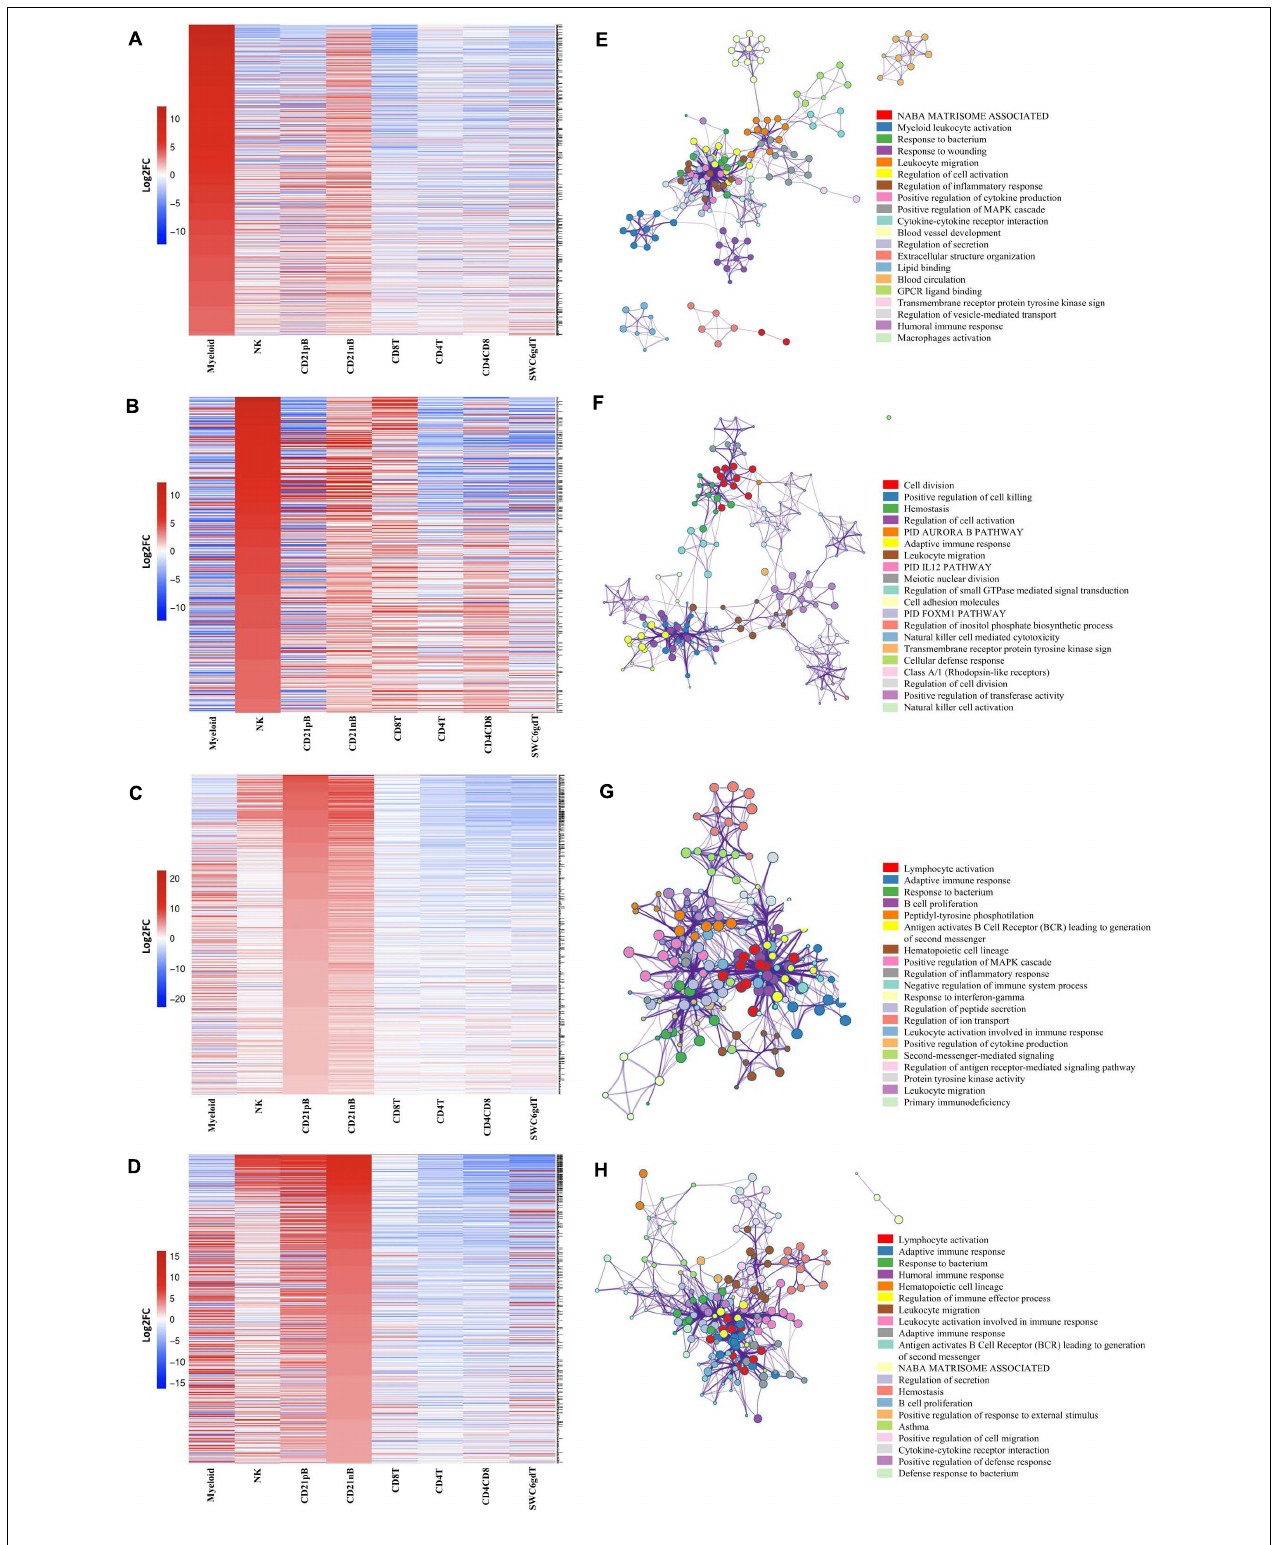
FIGURE 3 | Top 25% highly enriched genes in CD3 − sorted cells. Heatmap showing in decreasing order the top 25% of highly enriched genes in (A) myeloid, (B) NK, (C) CD21pB, and (D) CD21nB-cells. Ontology enrichment clusters of the top 25% highly enriched genes of (E) myeloid, (F) NK, (G) CD21pB, and (H) CD21nB cells. The most statistically significant term within similar term cluster was chosen to represent the cluster. Term color is given by cluster ID and the size of the terms is given by –log10 p -value. The stronger the similarity among terms, the thicker the edges between them.